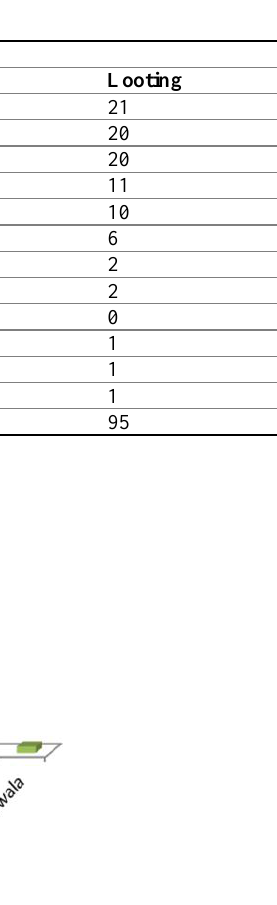
Figure 1: Impact of 2021 unrest on Schools in KZN Districts (Source: Authors’ survey) Research and